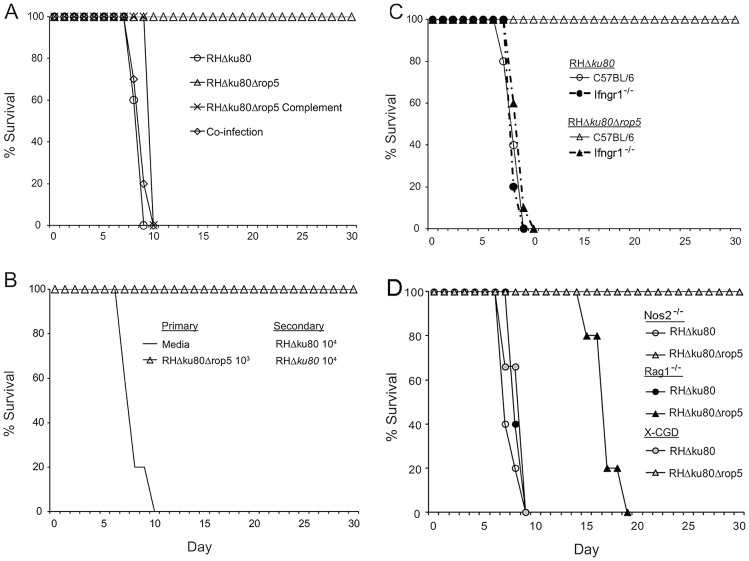
ROP5 deficient parasites vaccinate against lethal challenge and IFN-γ signaling is required for control of Δrop5 parasites.(A) CD-1 mice were separately injected i.p. with 103 wild type (RHΔku80), ROP5 deficient (RHΔku80Δrop5) or ROP5 complemented (RHΔku80Δrop5Complement) parasites, or co-infected with 103 each of wild type (RHΔku80) and ROP5 deficient (RHΔku80Δrop5) parasites. Survival was followed for 30 days. Mean values shown per group (n = 5). Representative of 2 experiments with similar outcomes. (B) CD-1 mice were inoculated with either media alone or 103 ROP5 deficient (RHΔku80Δrop5) parasites. After 30 days, mice were challenged with 104 wild type (RHΔku80) parasites and survival followed for 30 days. Mean values shown per group (n = 5). Representative of 2 experiments with similar outcomes. (C) C57BL/6 control or Ifngr1−/− mice were i.p. injected with 103 wild type (RHΔku80) or ROP5 deficient (RHΔku80Δrop5) parasites and survival was followed for 30 days. Mean values shown per group (n = 5). Representative of 3 experiments with similar outcomes. (D) Nos2−/−, Rag1−/−, or X-CGD mice were injected i.p. with 103 wild type (RHΔku80) or ROP5 deficient (RHΔku80Δrop5) parasites and survival was followed for 30 days. Mean values shown per group (n = 5), except X-CGD mice (RHΔku80 n = 3 and RHΔku80Δrop5 n = 4). Representative of 2 experiments with similar outcomes.